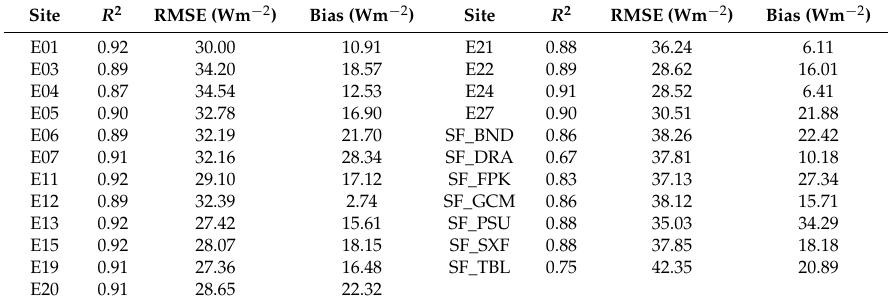
Table 8. Validation results between GLASS daytime R n and the observations of 25 validation sites.